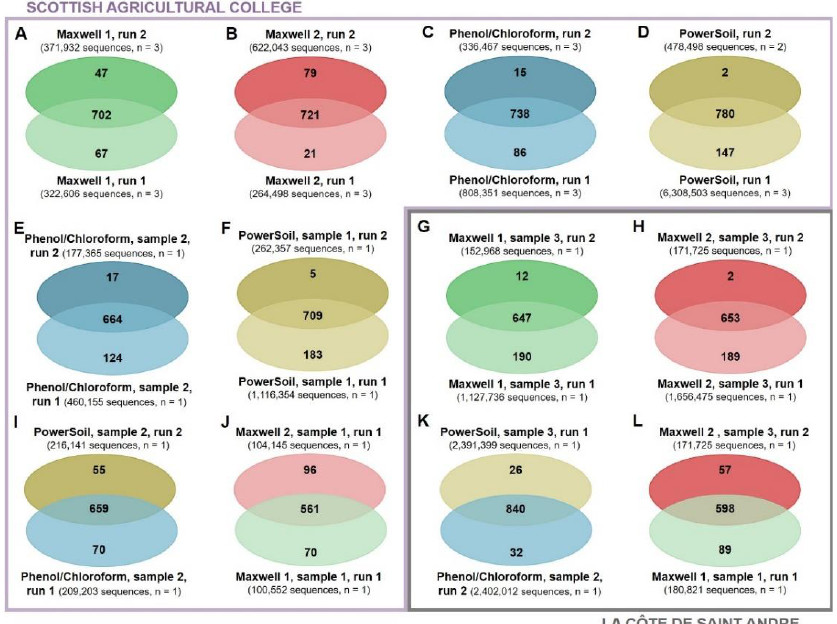
Figure 5. Venn Diagrams representing shared and unique functional classes from triplicates extracted using the same method sequenced in two different runs ( A – D ): individual samples sequenced at different depths ( E – H ) and samples extracted using different methods and sequenced at similar depths ( I – L ). Maxwell 1 and 2: modifications of the prototype Maxwell RSC Fecal Microbiome DNA Kit (Promega). PowerSoil: DNeasy PowerSoil Kit (QIAGEN).